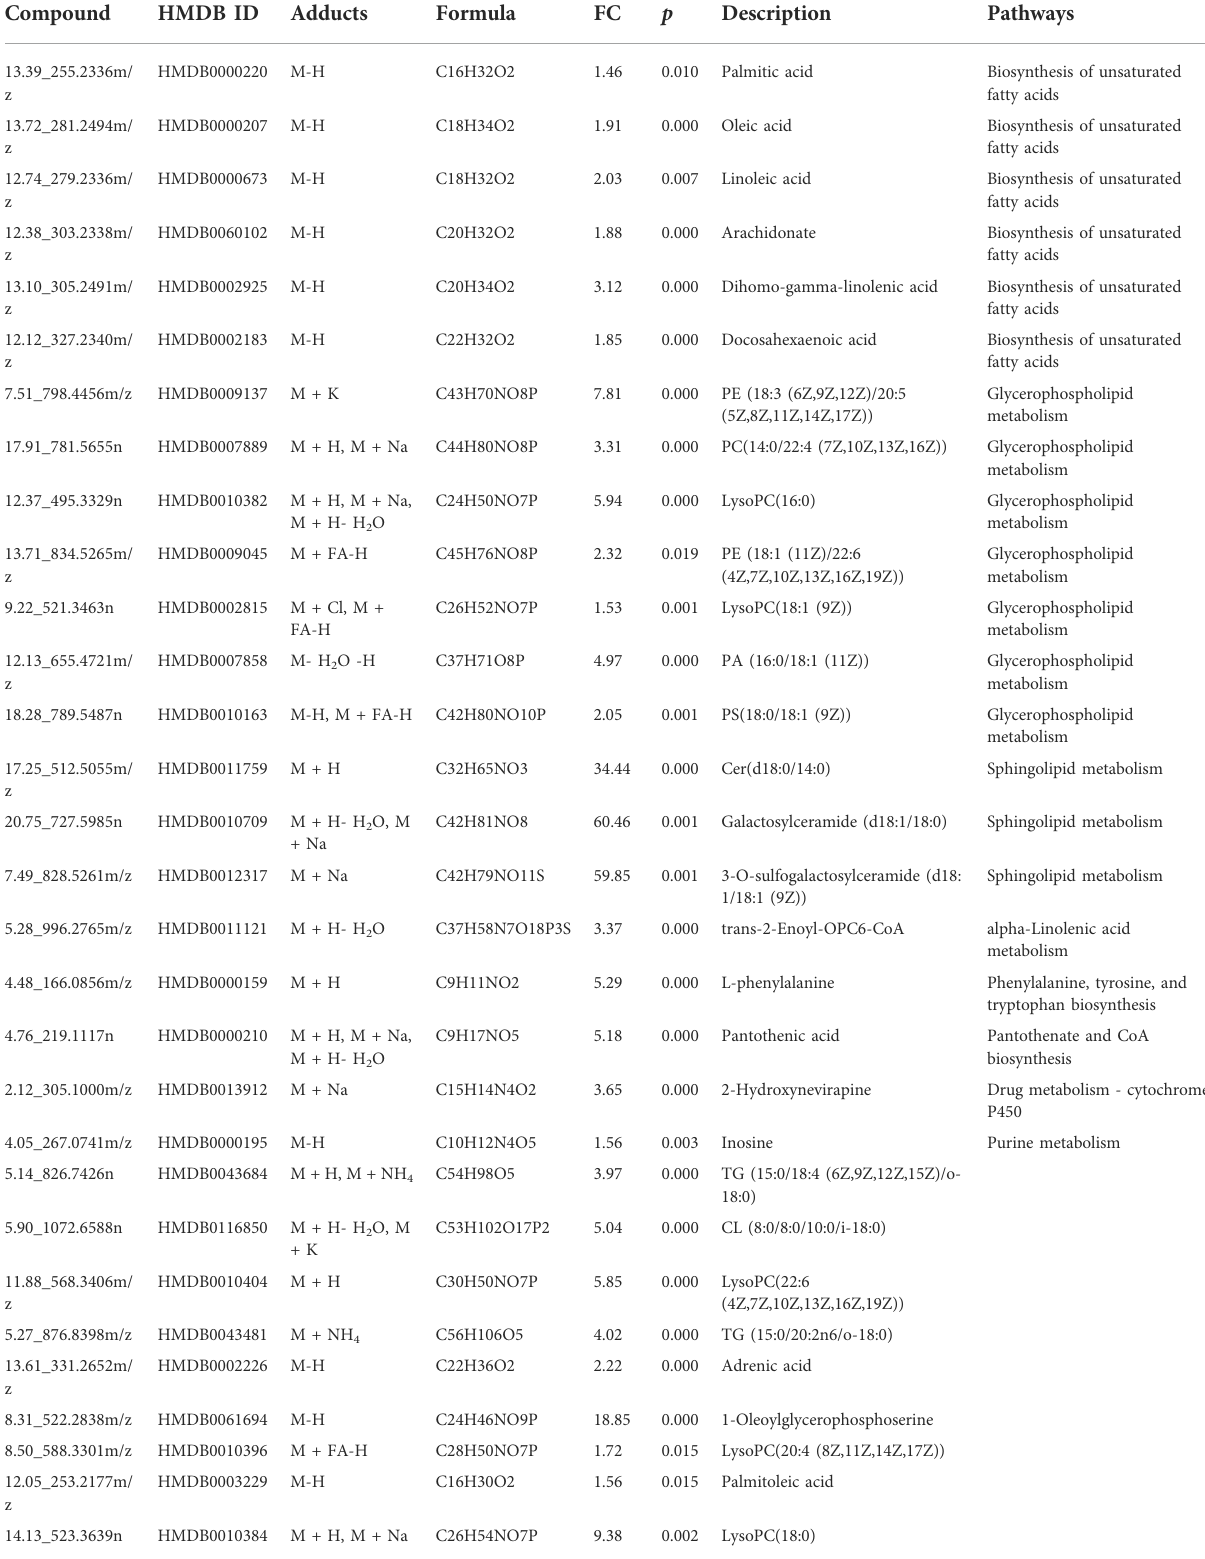
TABLE 1 Potential biomarkers found in the